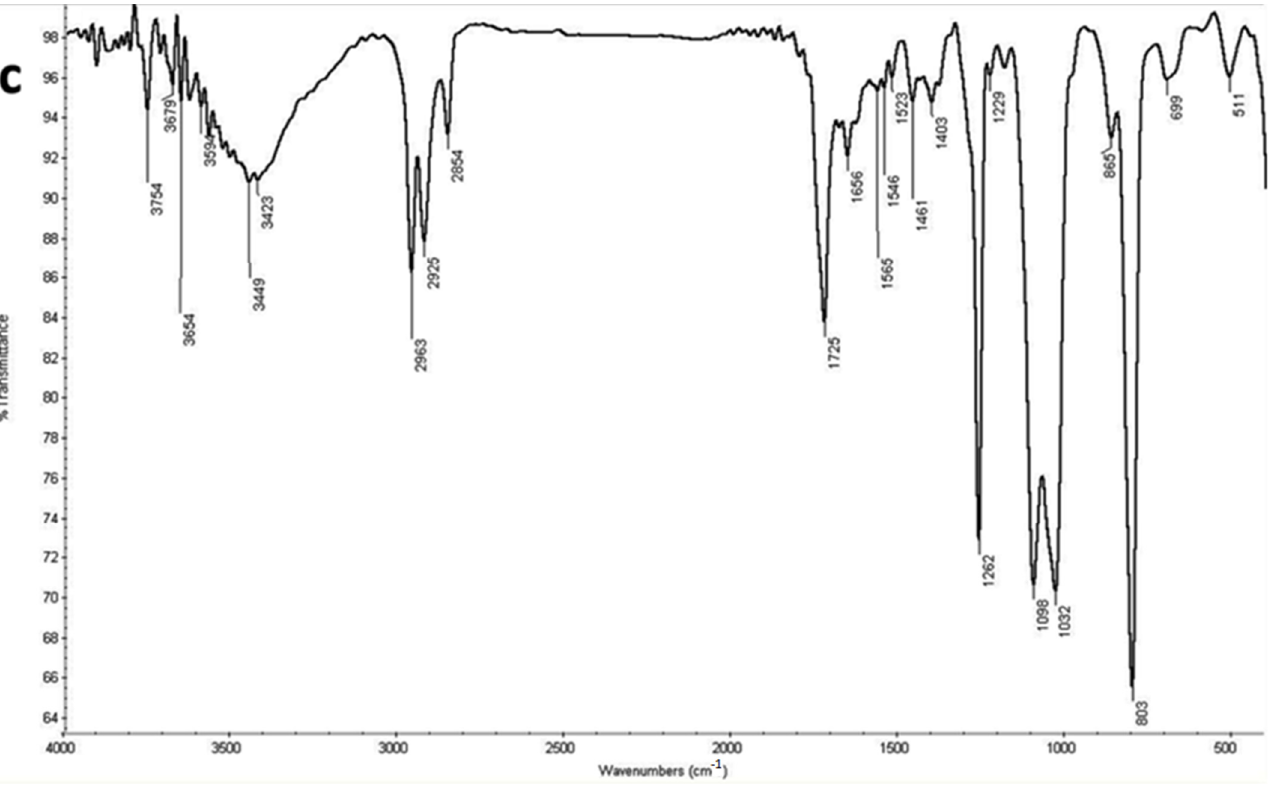
Figure 2. IR spectrum of PHB extracted from B. paramycoides ( a ), A. salinestris ( b ), and Brevundimonas naejangsanensis ( c ). Polymers 2021 , 13 , x FOR PEER REVIEW